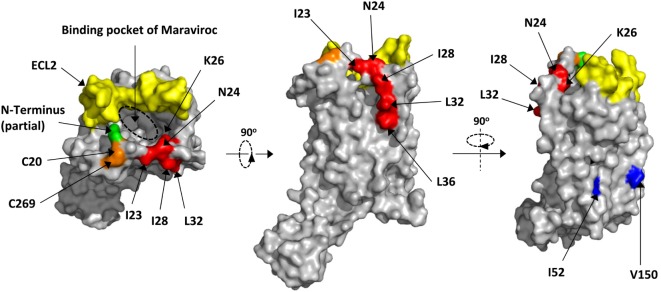
Location of key residues on the structure of C–C chemokine receptor type 5 (CCR5). The key residues were highlighted in red on the structure of CCR5. The surface was generated by Pymol based on 4MBS (7). The binding pocket of Maraviroc was indicated by dashed circle. The key residues for dimerization were highlighted in blue. The partial N-terminus was highlighted in green, while the ECL2 and disulfide bond were in yellow and orange, respectively.